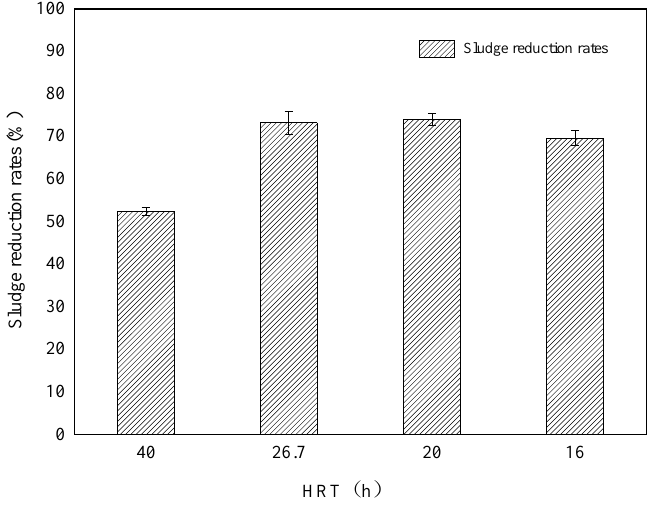
Figure 3. Sludge reduction rates at different HRTs.